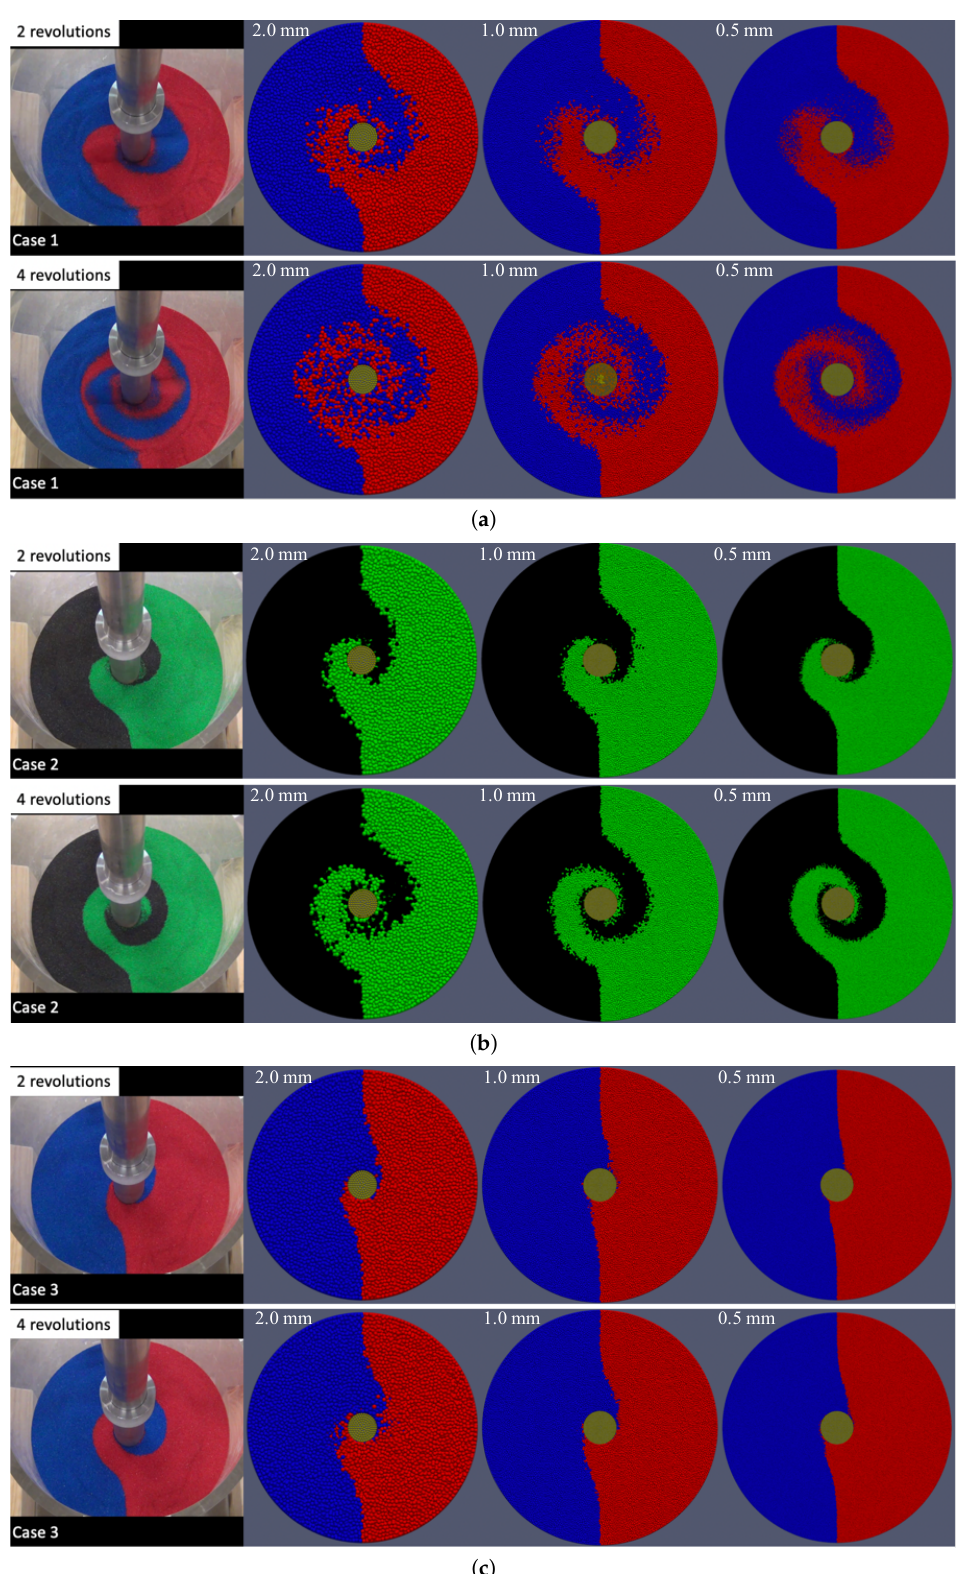
Figure 10. Comparison of surface mixing patterns for Case 1 ( a ), for Case 2 ( b ), and for Case 3 ( c